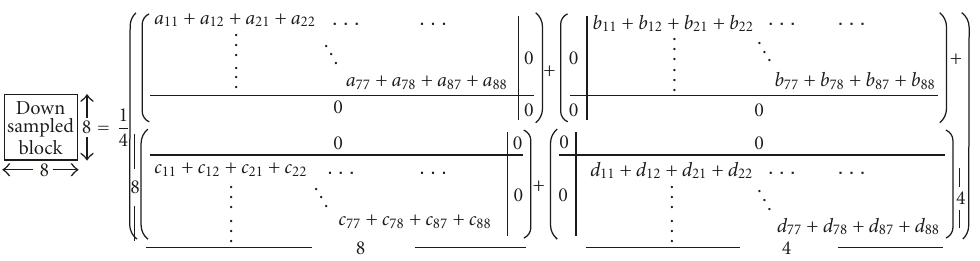
Figure 2: Pixel averaging and down-sampling performed on 8 × 8 block